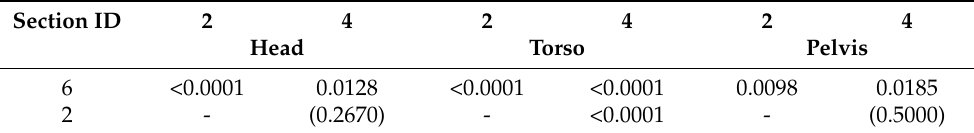
Table 3. p -value test for pairwise comparisons at the prominent peak frequency of the HVM group at the head, torso, and pelvis relative to the vehicle